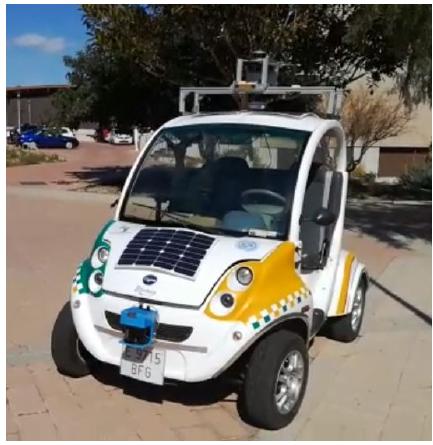
Figure 5. The autonomous vehicle prototype employed in this